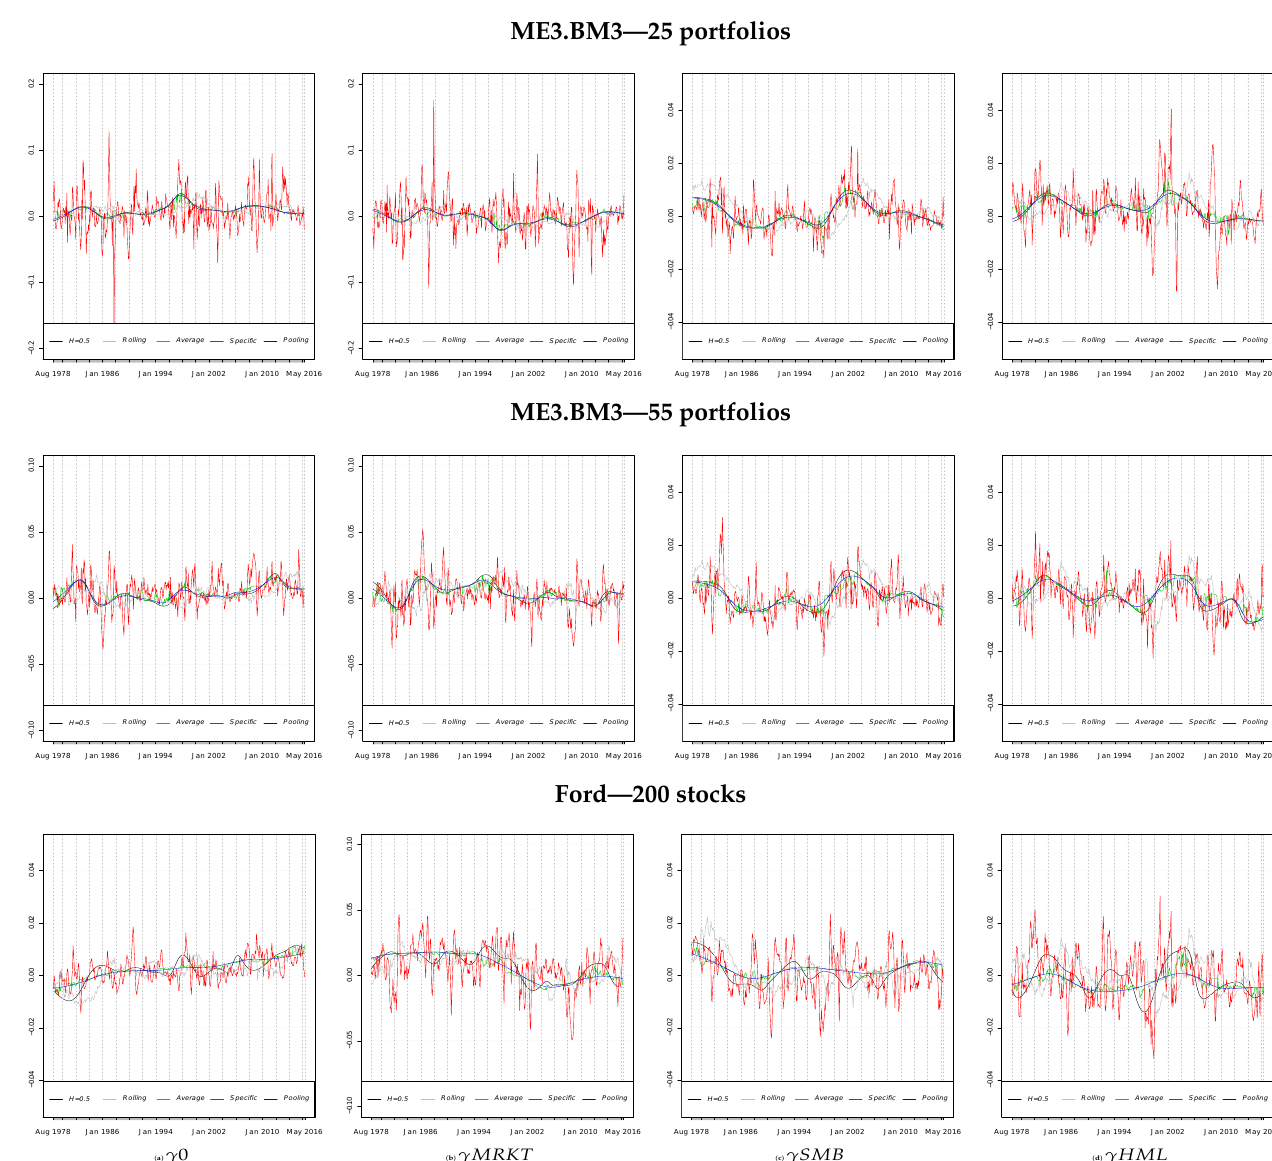
Figure 3. Dynamic comparison of risk premium estimates for different approaches. Note : The figure provides the estimates of risk premium estimates computed using factor risk loadings calculated with Rolling window, with a 5-year estimation period ( FMcB approach, green line) and kernel-weighted regressions using 4 different optimal bandwidths; h = 0.5 (black line); Polling a single value of h coming from the poll average across assets and time, as shown in Equation (7)) (purple line); Average , a unique time-varying bandwidth coming from the average of h across assets (Equation (8); blue line); Specific , multiple time-varying bandwidths, one for each asset and time (red line). The choice of the optimal bandwidth parameter h opt was made using the kernel approach for the computation of the t time-varying RMSE , as discussed in Equation